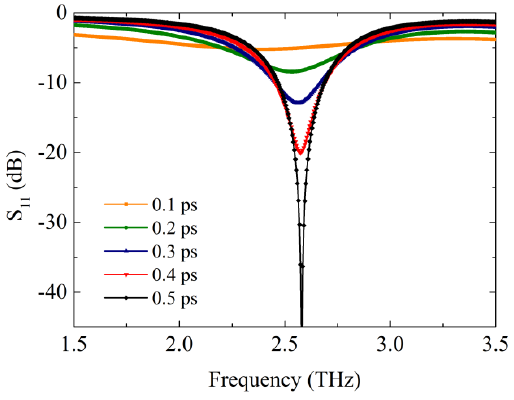
Figure 6. Simulated reflection coefficient with different relaxation times, 0.1 ps, 0.2 ps, 0.3 ps, 0.4 ps, and 0.5 ps. The arm length is 5 µm and the temperature is 300 K.